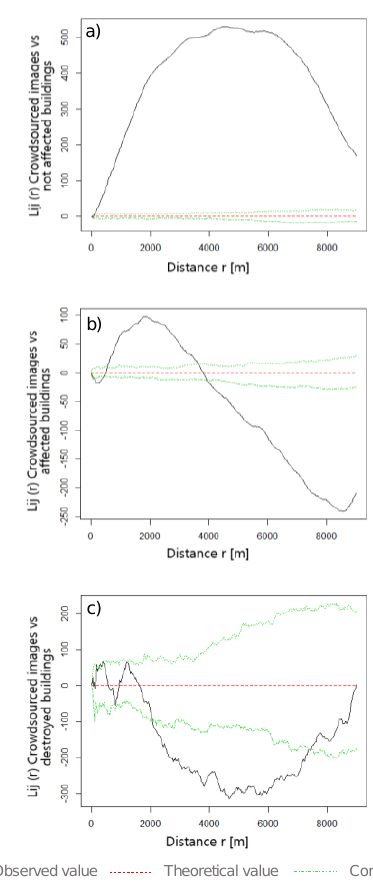
Figure 6. Cross-function L ij for a) crowdsourced images and not affected buildings, b) crowdsourced images and affected buildings, c) crowdsourced images and destroyed buildings The results show that cross-correlation between crowdsourced images and not affected buildings (Figure 6a) is positive and lies above the Monte-Carlo simulation envelope (99% confidence interval). The high magnitude from the upper boundary of the confidence interval indicates significant interactions between crowdsourced images and not affected buildings for all distance ranges. A bit different distribution of the cross-correlation between crowdsourced images and affected buildings has been recorded (Figure 6b). The computed L ij is negative and inside the confidence interval for small distances (r < 500 m approximately), indicating not significant interactions. Furthermore, for the distances between 0.5 km and 4 km the distribution is positive and above the confidence interval, indicating the attraction between the crowdsourced images and affected buildings. This means that in a 0.5 to 4 km radius, the number of crowdsourced images surrounded by randomly chosen affected buildings is greater than expected if the two patterns are independent. For a distance of 4 km or more, repulsion between two observed objects has been found. Analysing the relationship between the crowdsourced photos and the destroyed buildings (Figure 6c), the distribution of the cross-correlation lies inside the envelope for distances smaller than 2 km and for distances larger than 7 km, suggesting not significant interactions between crowdsourced photos and destroyed buildings. For the remaining distances (2 km < r < 7 km approximately) the repulsion has been